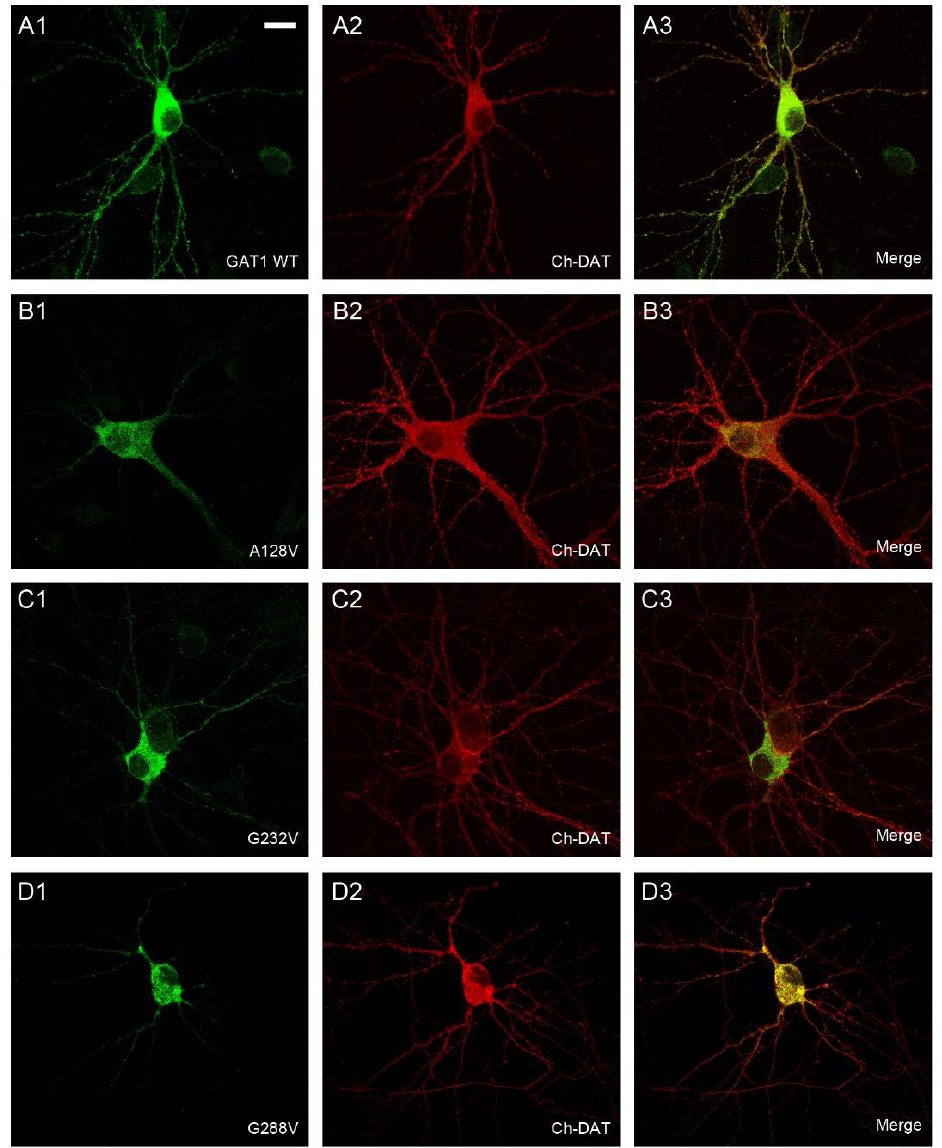
Figure 6. Subcellular distribution of GAT-1 variants in transfected neurons. Primary cultures of rat cortical neurons were co-transfected at 13 DIV with mCherry-DAT plus the indicated variants of HA-GAT-1: HA-GAT1 WT ( A1 – A3 ); A128V ( B1 – B3 ); G232V ( C1 – C3 ); G288V ( D1 – D3 ). 48 h later, cells were fixed and incubated with anti-HA and anti-mCherry primary antibodies followed by Alexa Fluor-labeled secondary antibodies. Images collected by confocal microscopy correspond to the distribution of HA-GAT-1 variants (green channel; A1 , B1 , C1 , D1 ), mCherry-DAT (red channel; A2 , B2 , C2 , D2 ) or the merge ( A3 , B3 , C3 , D3 ). Scale bar: 15 µ